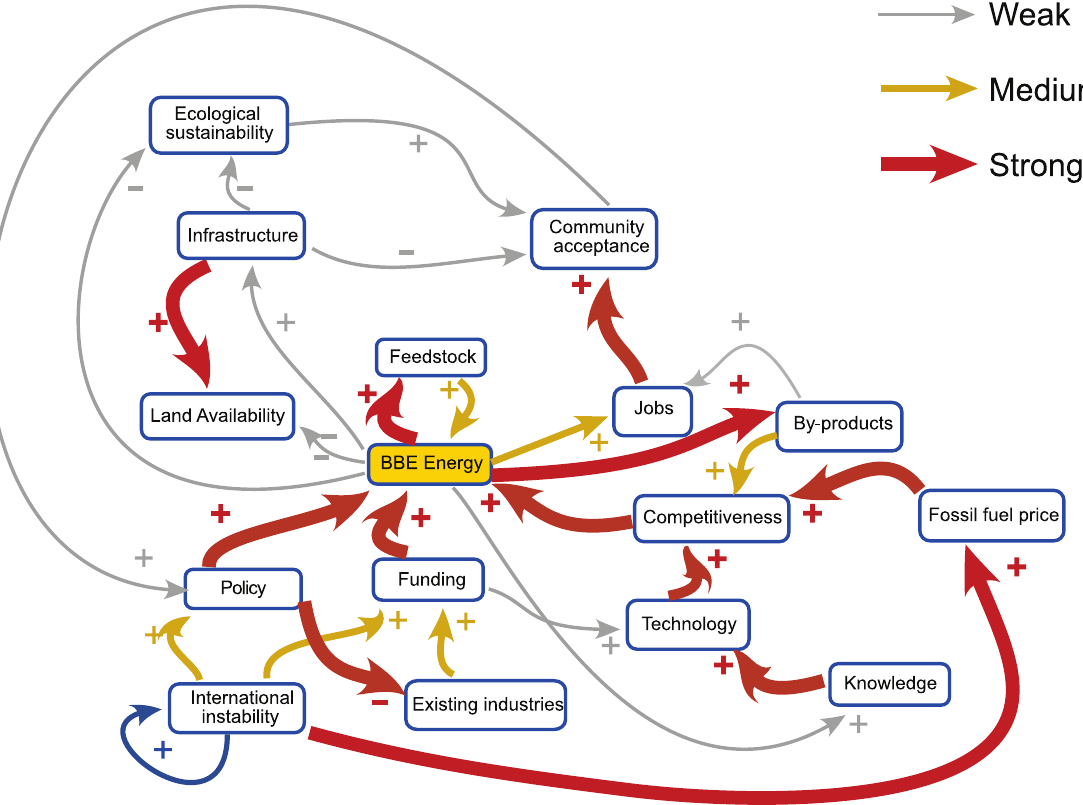
Figure 3. Modified FCM from the Humber Environmental Managers’ Meeting showing the addition of a link from international instability to fossil fuel price. Thickness of the links denotes the strength of the influence.